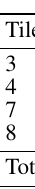
Table 1. Number of building instances per tile.